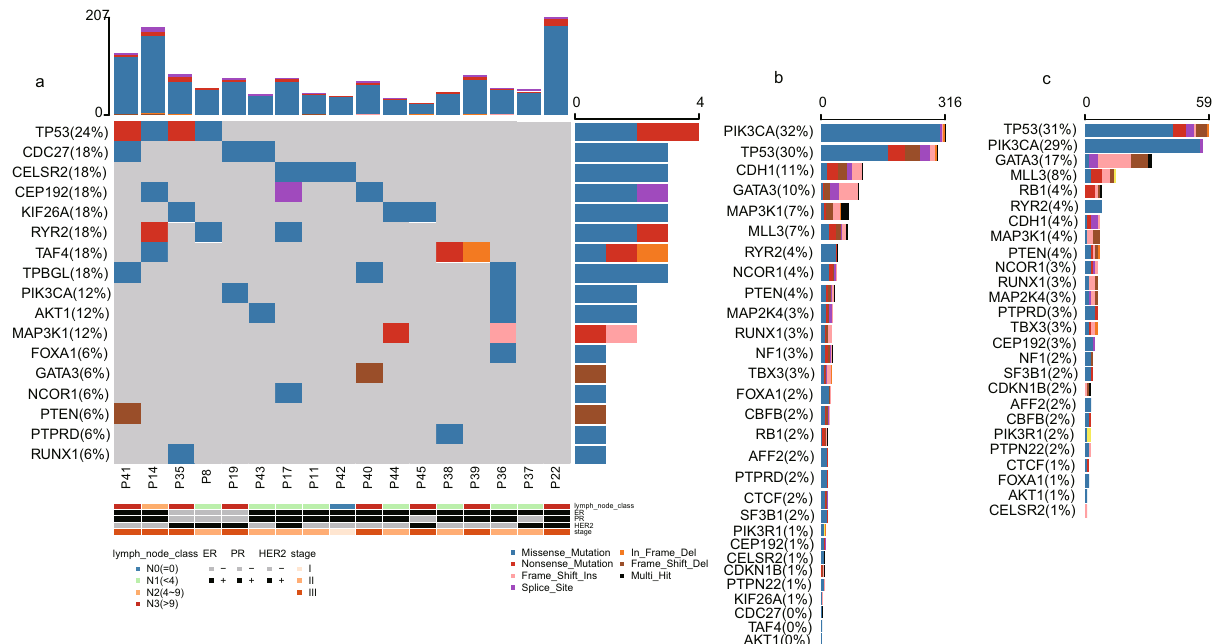
Fig. 1 IMPC genomic somatic mutation landscape in 17 freshly frozen IMPC tumor-normal tissue pairs. a Non-silent somatic mutation patterns and frequencies of the most highly mutated genes (present in at least 3 samples: TP53 , CDC27 , CELSR2 , CEP192 , KIF26A , RYR2 , TAF4 , TPBGL , and known breast cancer-related genes PIK3CA , AKT1 , MAP3K1 , FOXA1 , GATA3 , NCOR1 , PTEN , PTPRD , and RUNX1 ; known breast cancer-related genes MAP2K4 , MLL3 , CDH1 , PIK3R1 , CBFB , TBX3 , CTCF , SF3B1 , CDKN1B , RB1 , AFF2 , NF1 , and PTPN22 that are not shown in the fi gure did not contain mutations). The percentages on the left show the frequencies of gene mutation, and the bars on the top and right represent the number of different mutations in each sample and the sample number in each gene, respectively. b The same non-silent somatic gene mutations as shown in a with patterns and frequencies for TCGA breast cancer dataset. c The same non-silent somatic gene mutations as shown in a with patterns and frequencies for TCGA luminal B breast cancer